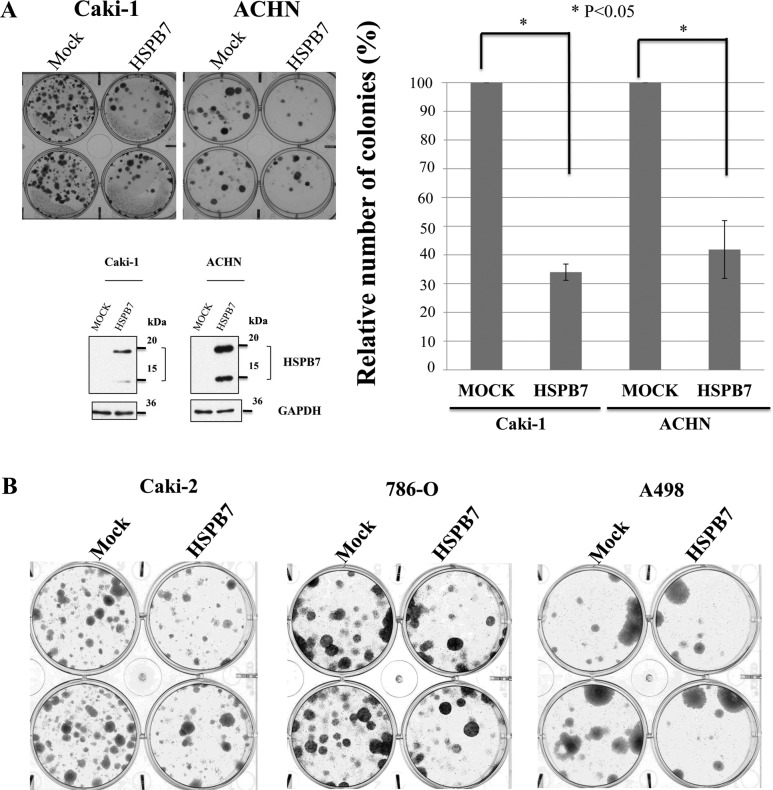
Ectopic HSPB7 expression suppresses RCC cell growth. (A) Colony formation assay showed that introduction of HSPB7 impaired colony-forming ability of Caki-1 and ACHN cells. Cells were transfected with plasmid expressing HSPB7 or mock plasmid, and colonies (>1 mm diameter) were counted after selection of 2–3 weeks with G418. At 48 h after transfection, total protein of cells was collected and applied for western blot to confirm the successful transfection. GAPDH was used for the normalization of protein expression levels. (B) Colony formation assay in Caki-2, 786-O and A498 RCC cell lines. Values are expressed as the mean ± SD.